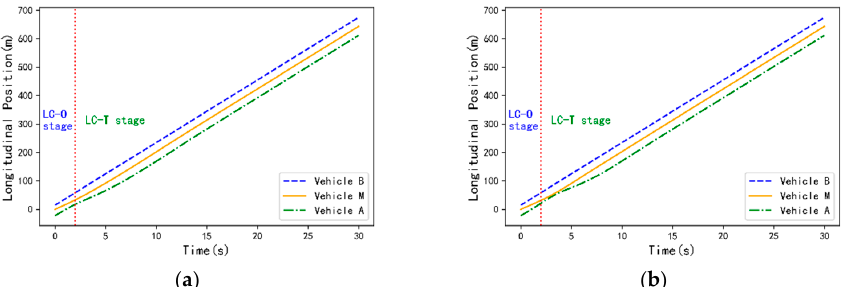
Figure 6. The longitudinal positions of vehicles B, M, and A of the two control strategies in scenario 1. ( a ) The proposed CLC control strategy, ( b ) CACC_Sine control strategy.